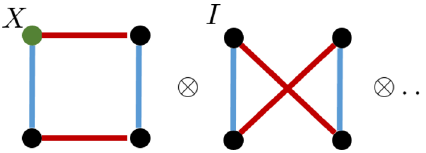
Figure 51. For six copies, we find that there are certain configurations where the gauge pushing does not allow an equivalent operator on arbitrary two sites without leaving the code